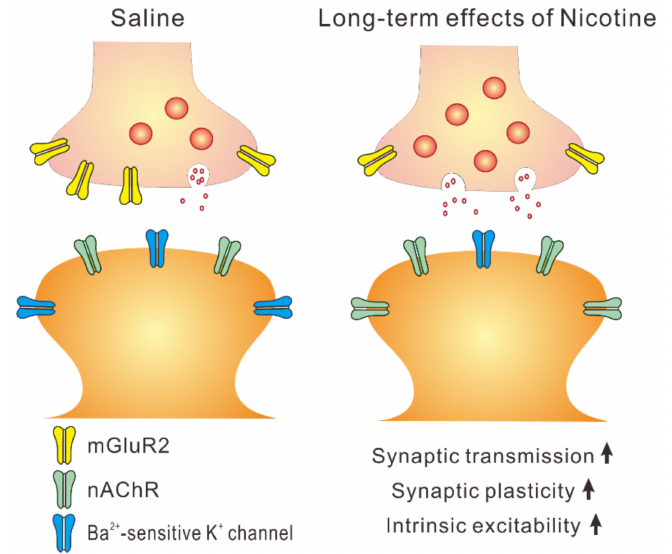
Figure 7. A possible model for long-term effects of adolescent nicotine exposure in layer V PNs of the mice insular